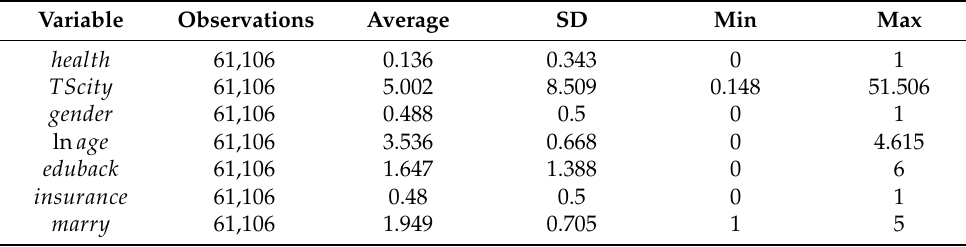
Table 1. Data and statistical description of